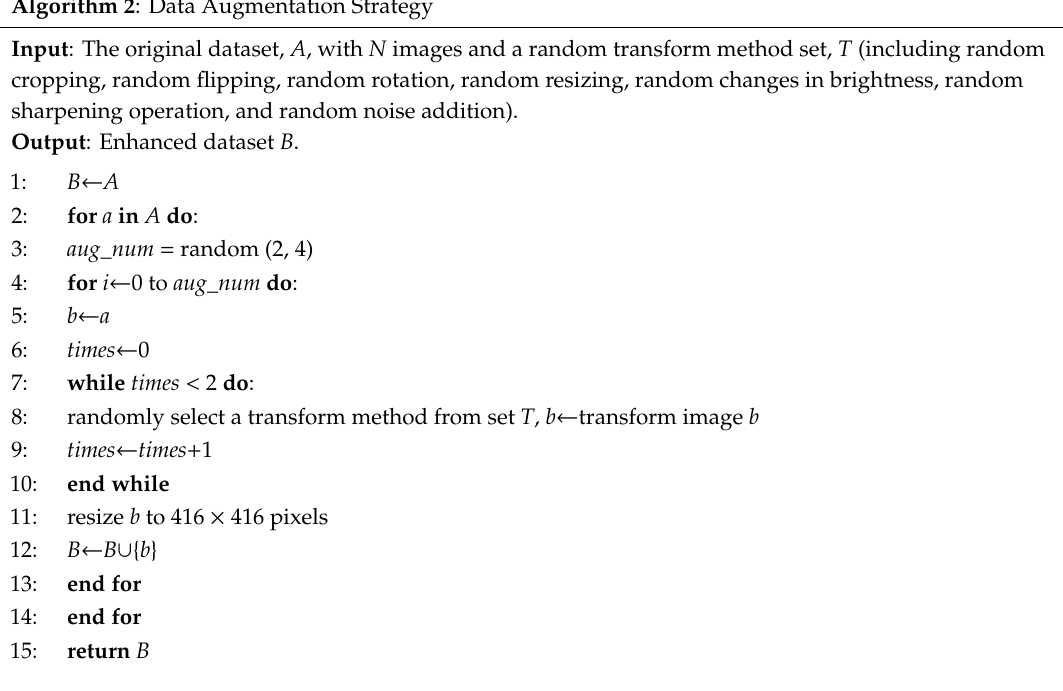
Algorithm 2 : Data Augmentation